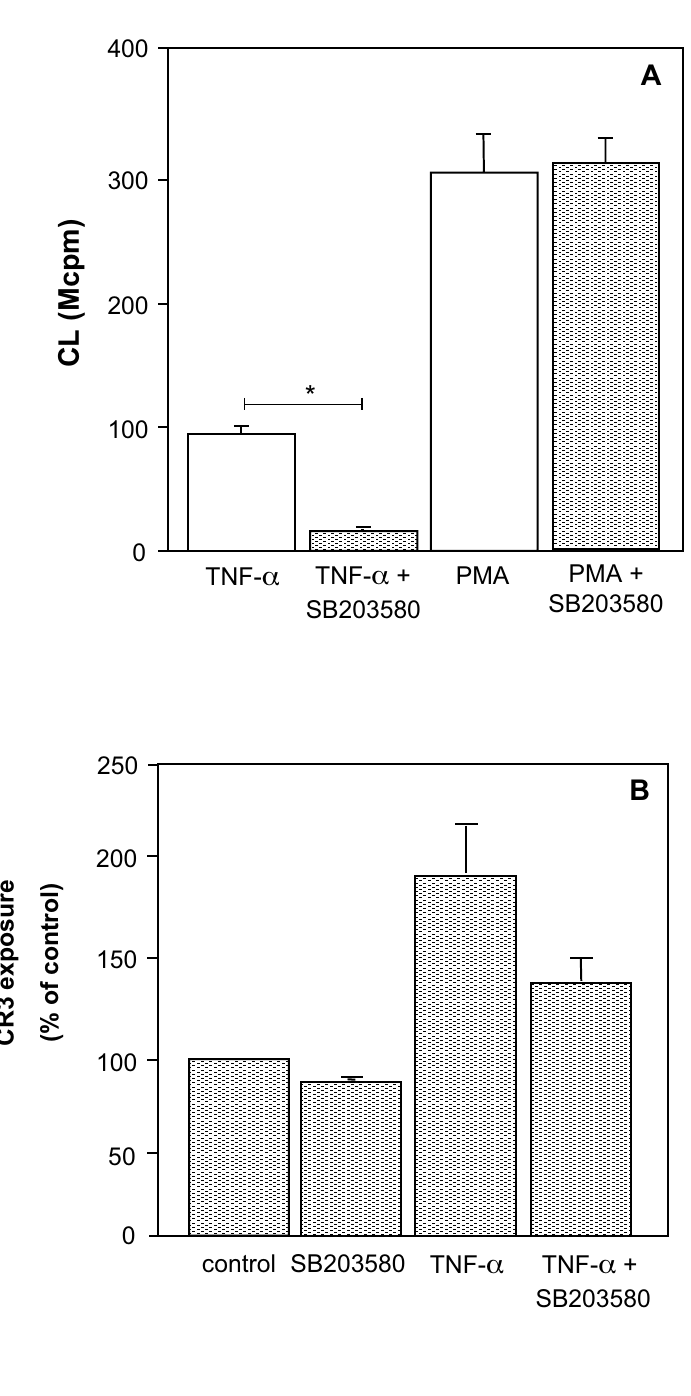
Figure 10 Effects of SB203580 on TNF- α priming. Neutrophils were primed by TNF- α (25 ng/ml, 20 min, 37°C) in the absence or presence of the p38 MAPK inhibitor SB203580 (1 µ M). (A) The cells were stimulated with cytochalasin B (5 µ g/ml) and the extracellular production of superoxide anion was measured by CL. The effect of SB203580 on PMA-induced superoxide anion conjugated anti-CR3 antibodies (CD18/CD11b), analysed by flow cytometry and compared with control cells.